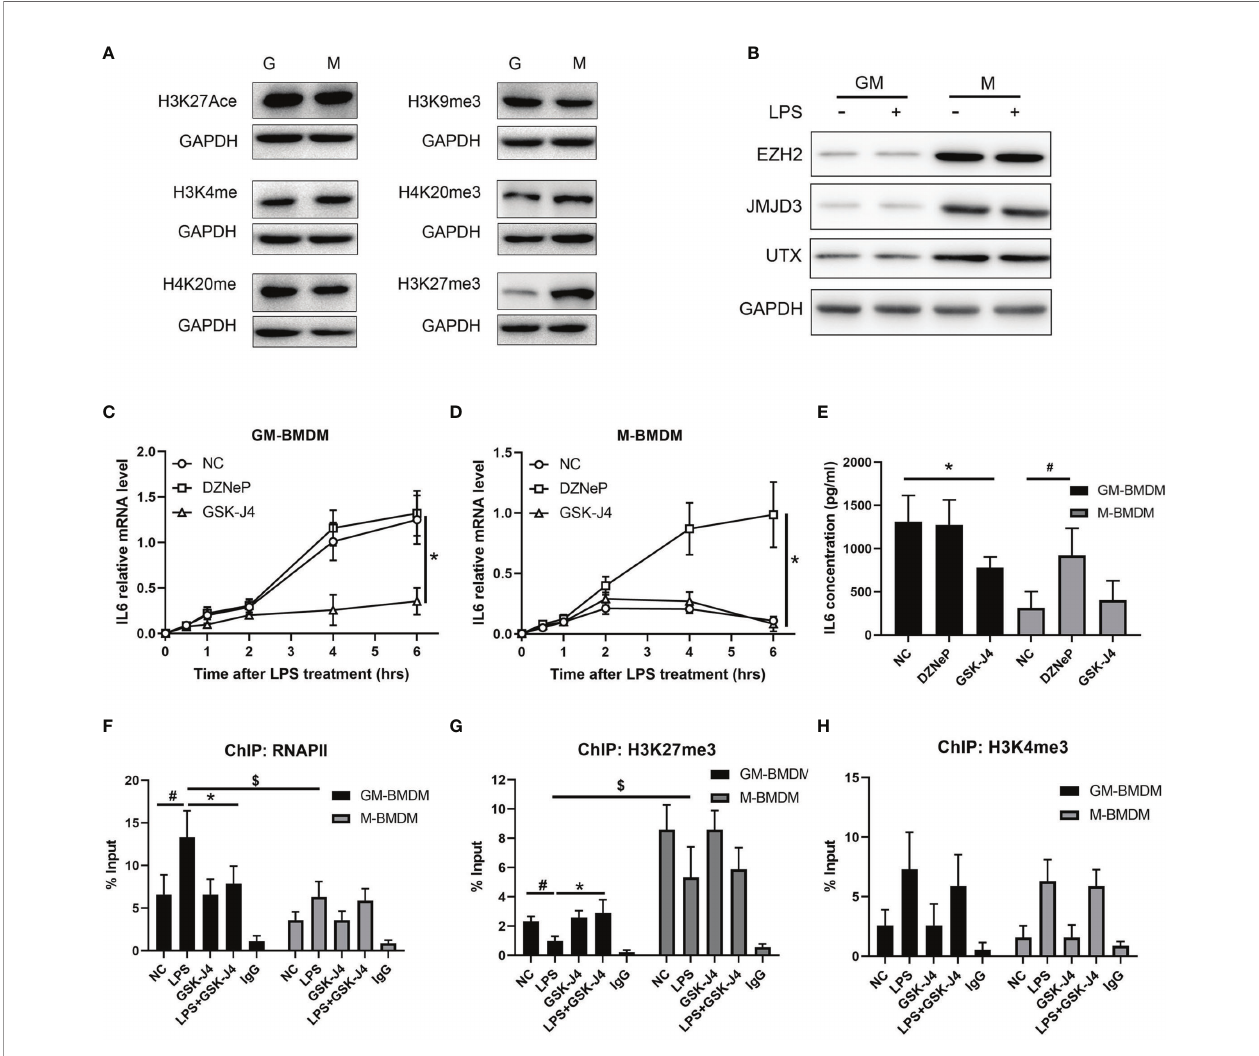
FIGURE 4 | GSK-J4 inhibits IL6 expression via regulating H3K27me3 activity in macrophages. (A) Levels of epigenetic modi fi cations (H3K27Ace, H3K4me3, H4K20me, H3K9me3, H4K20me3, H3K27me3) were detected in GM-BMDMs and M-BMDMs. (B) BMDMs were stimulated with 100 ng/ml LPS for 2 hours, the expression levels of EZH2, JMJD3 and UTX were determined by Western Bot. (C, D) After exposing to DZNeP and GSK-J4 for 48 hours, qPCR determines IL6 mRNA level changes upon LPS stimulation in GM-BMDMs (C) and M-BMDMs (D) . (E) GM-BMDMs and M-BMDMs were stimulated with LPS (100 ng/ml) for 6 hours, the concentration of IL6 in the media were measured by ELISA. ChIP experiments were performed with anti-RNAPII (F) , anti-H3K27me3 (G) and anti- H3K4me3 (H) , the abundance of IL6 promoter fragment (-1000 to -900 bps relative to TSS) was determined by qPCR. p < 0.05 (two-tailed Student ’ s T-test) is indicated by * for comparison with LPS+GSK-J4 vs. LPS, # for comparison with NC vs. LPS, $ for comparison DZNeP vs. NC under LPS stimulation, error bars indicate